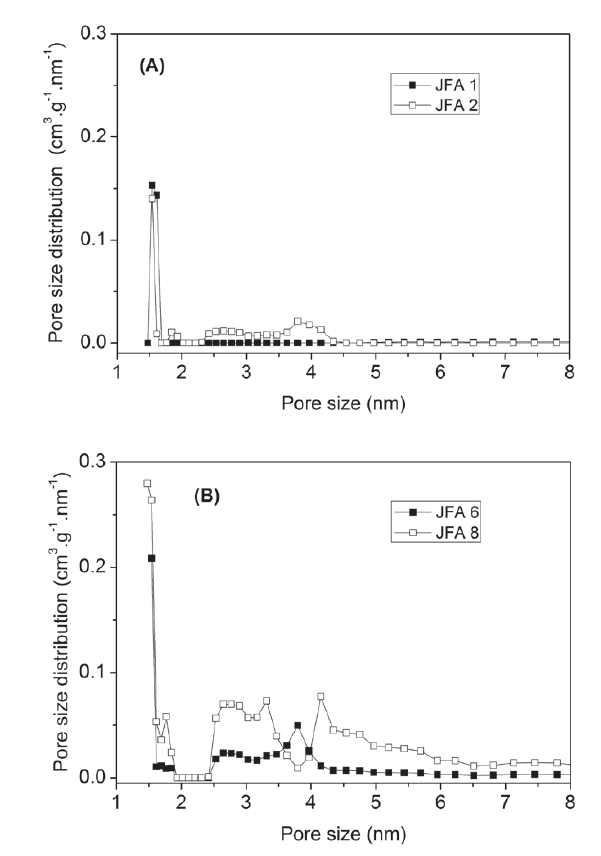
Fig. 5 - Pore size distribution: (A) sample JFA1 and JFA 2; (B) sample JFA6 and JFA8.